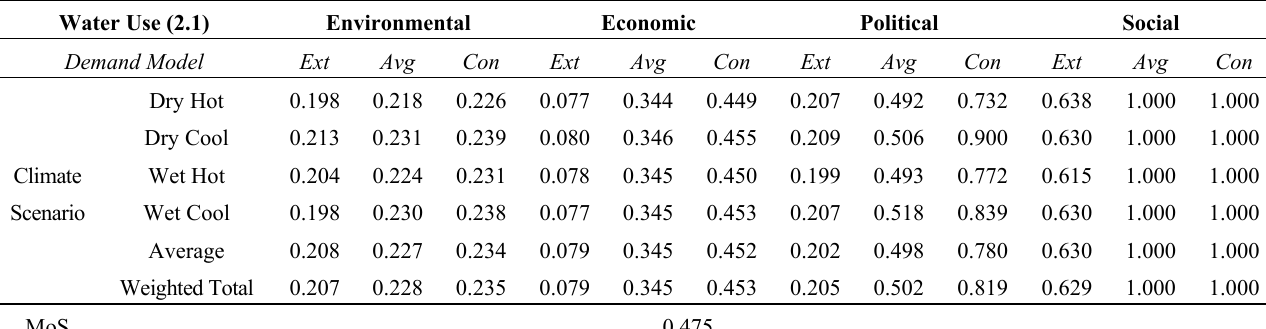
Table 9. Example table for the computation of MoS completed for each management option under Extreme (Ext), Average (Avg), and Conservative (Con) demand futures (using management scheme 2.1 as example).